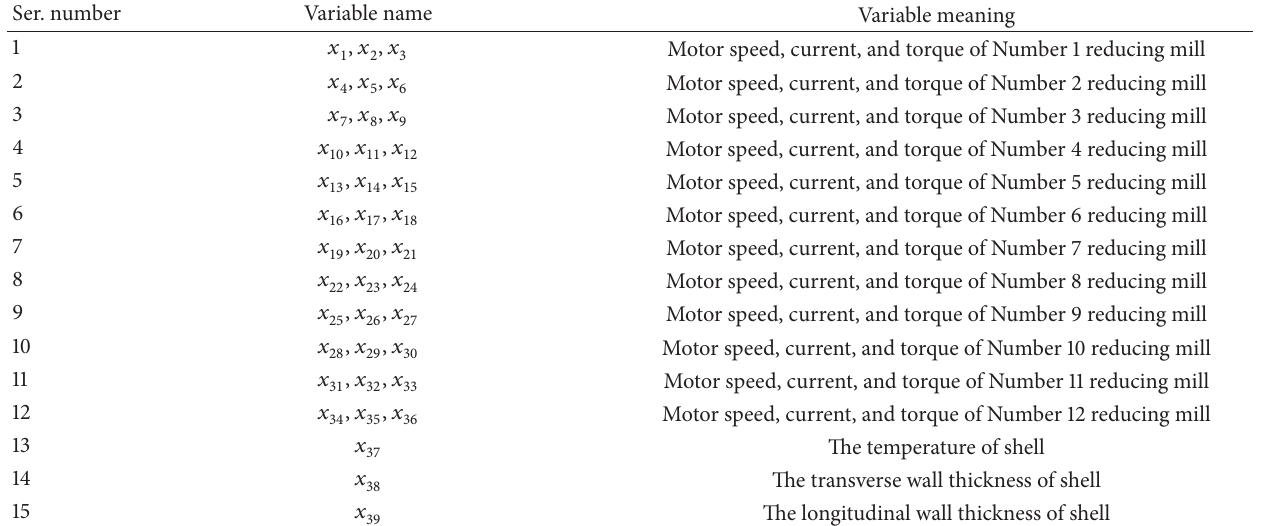
Table 2: Variable table for modeling of reducing tube